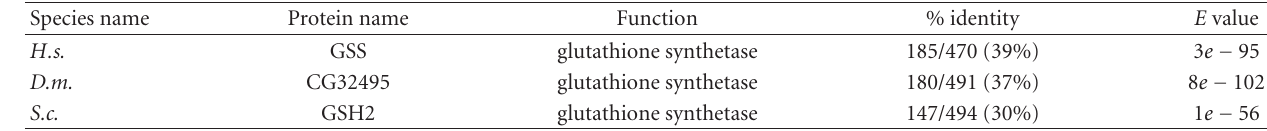
Table 2: Similarity between C . e glutathione synthetase and orthologues in H.s., S.c ., and D.m